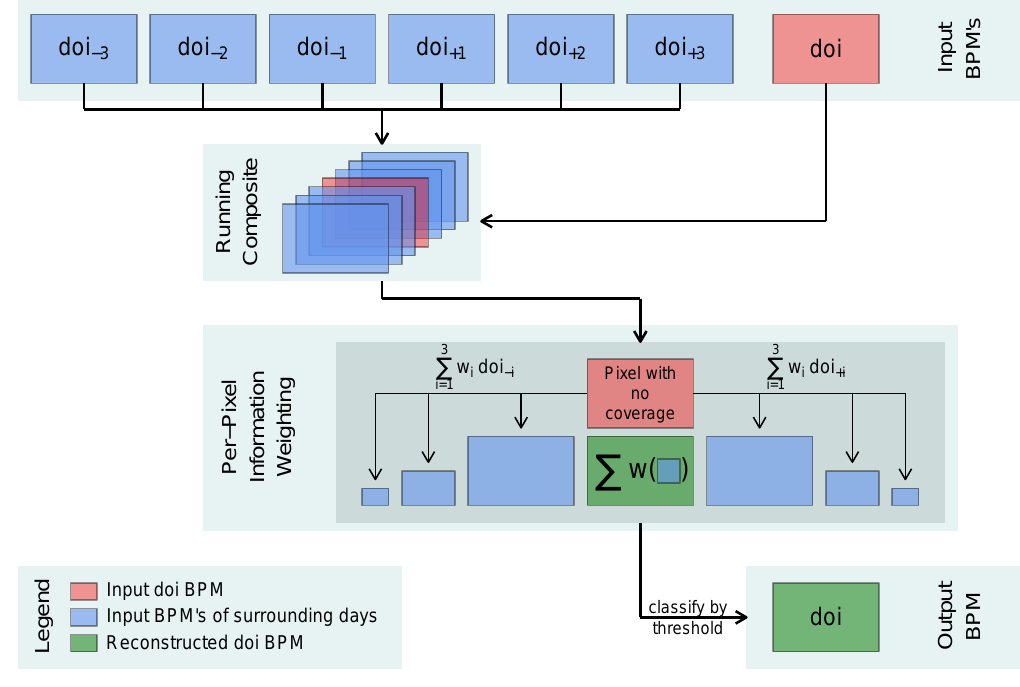
Figure 3. Flow chart of the general algorithm procedure. Binary polynya area maps (BPM) ...doi of the surrounding days ( doi , blue) are aggregated and weighted according to their − 3 +3 temporal proximity to the day of interest (doi, red). By passing a predefined threshold, each cloud-covered pixel in the initial day of interest is classified as polynya area or thick ice, resulting in a reconstructed BPM of the initial day of interest